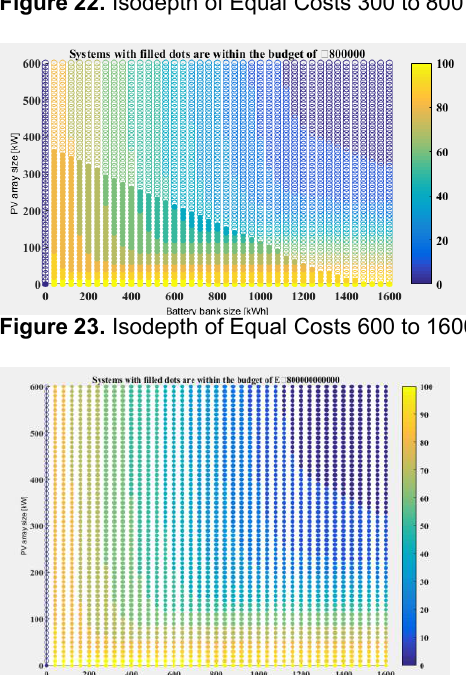
Figure 22. Isodepth of Equal Costs 300 to 800